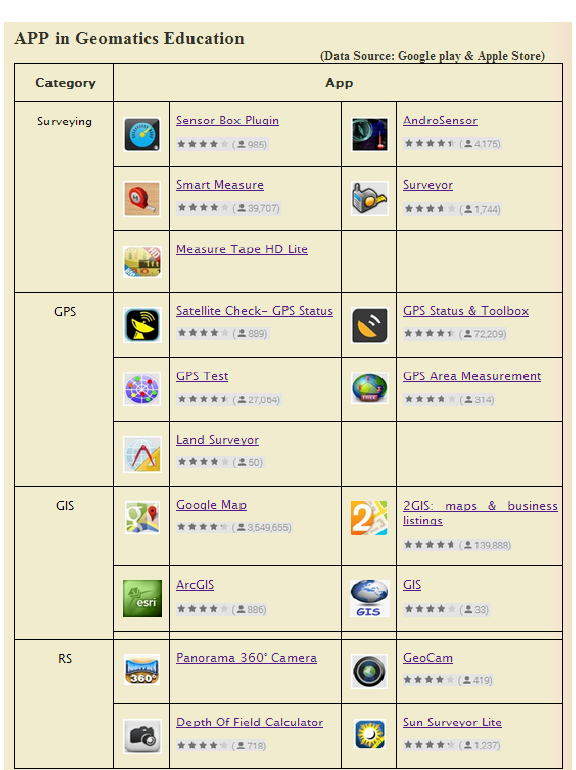
. Figure 8. The website of Apps in geomatics